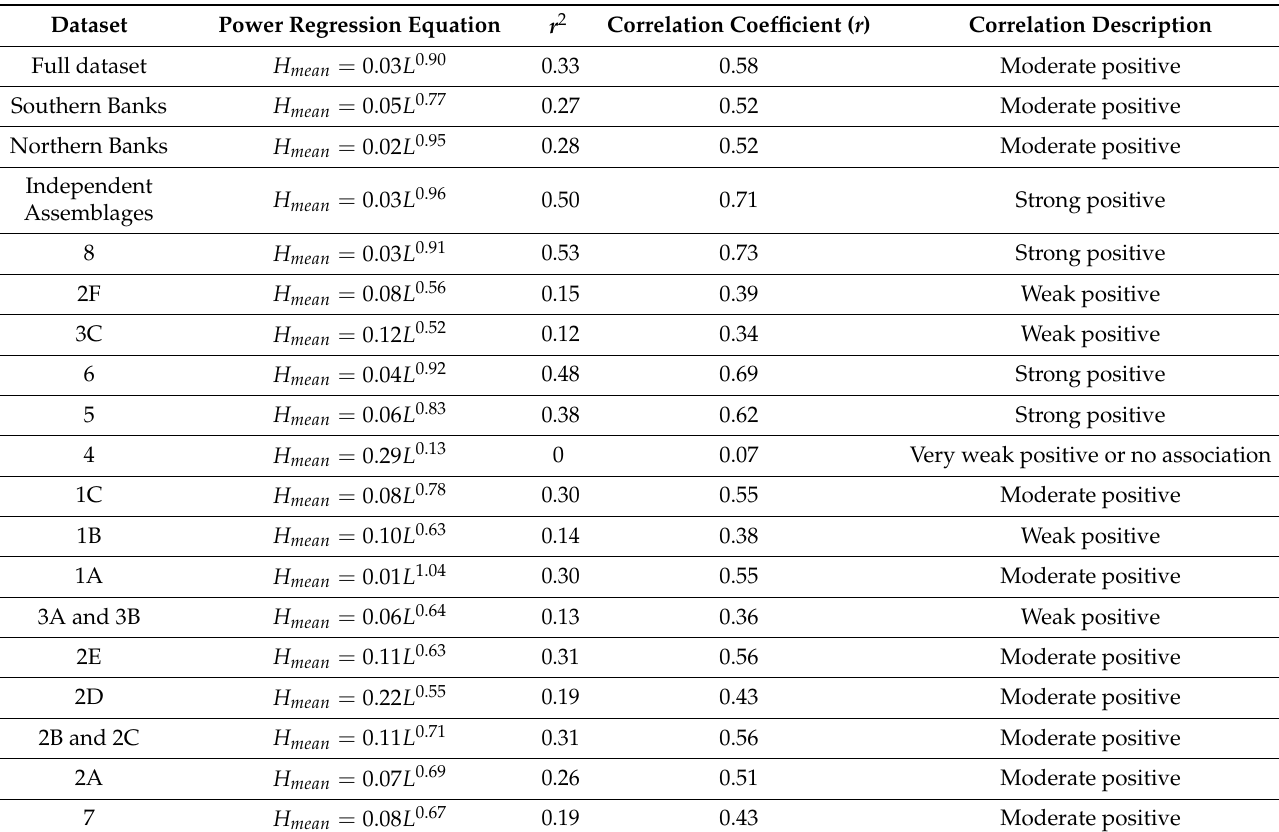
Table 5. Relationship between bedform heights and wavelengths in the south-western Irish Sea. The Full dataset has been broken into three environments i.e., Southern Banks, Northern Banks and Independent Assemblages, and each individual study